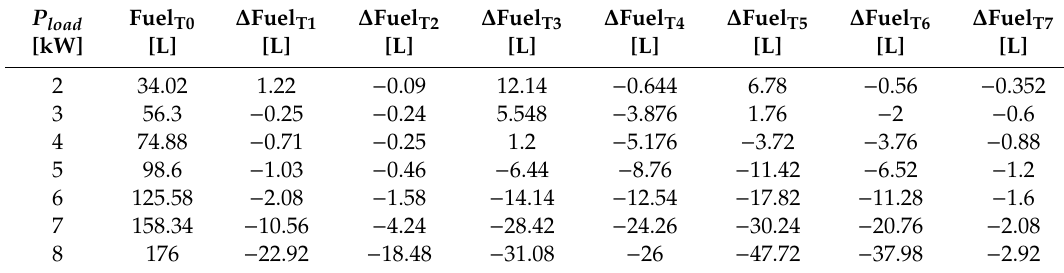
Table 3. Fuel economy for k fuel = 25 and di ff erent P load .